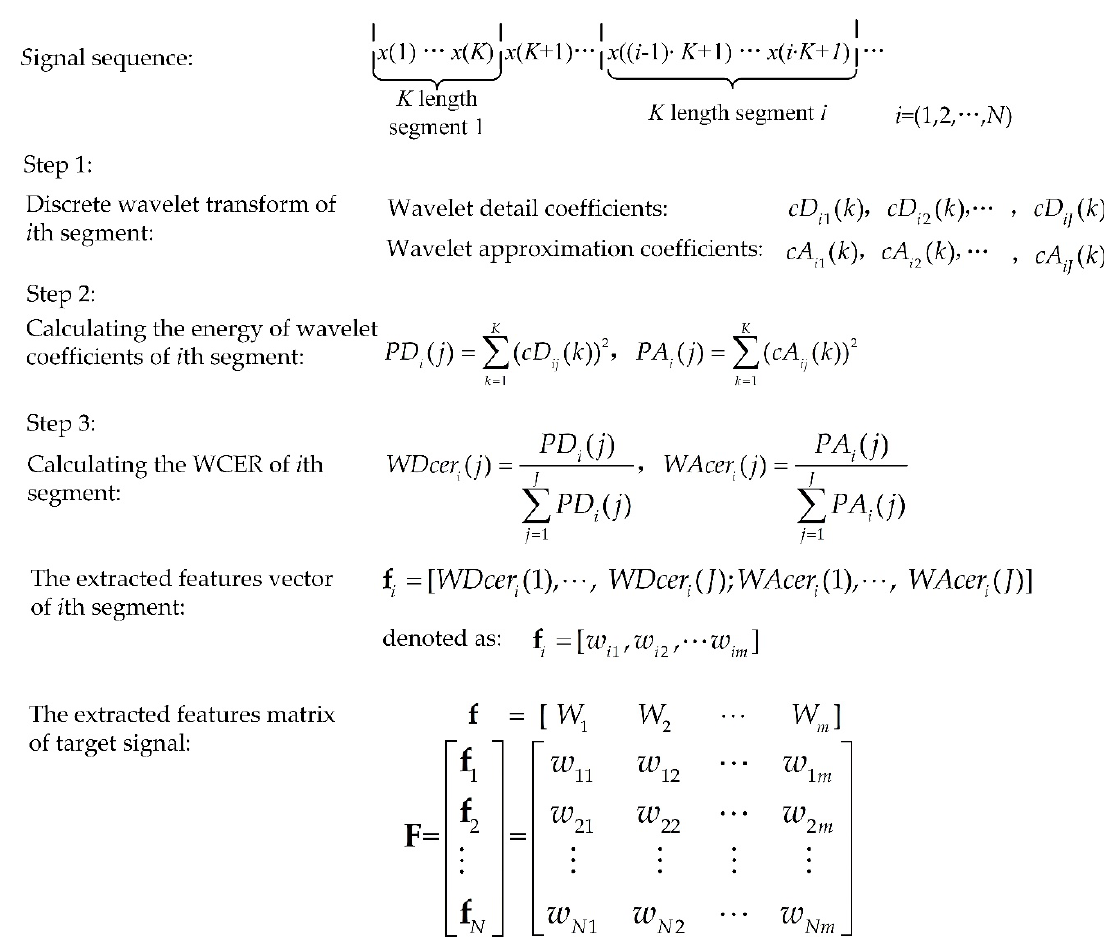
Figure 2. Process of feature extraction using wavelet coefficient energy ratio (WCER).